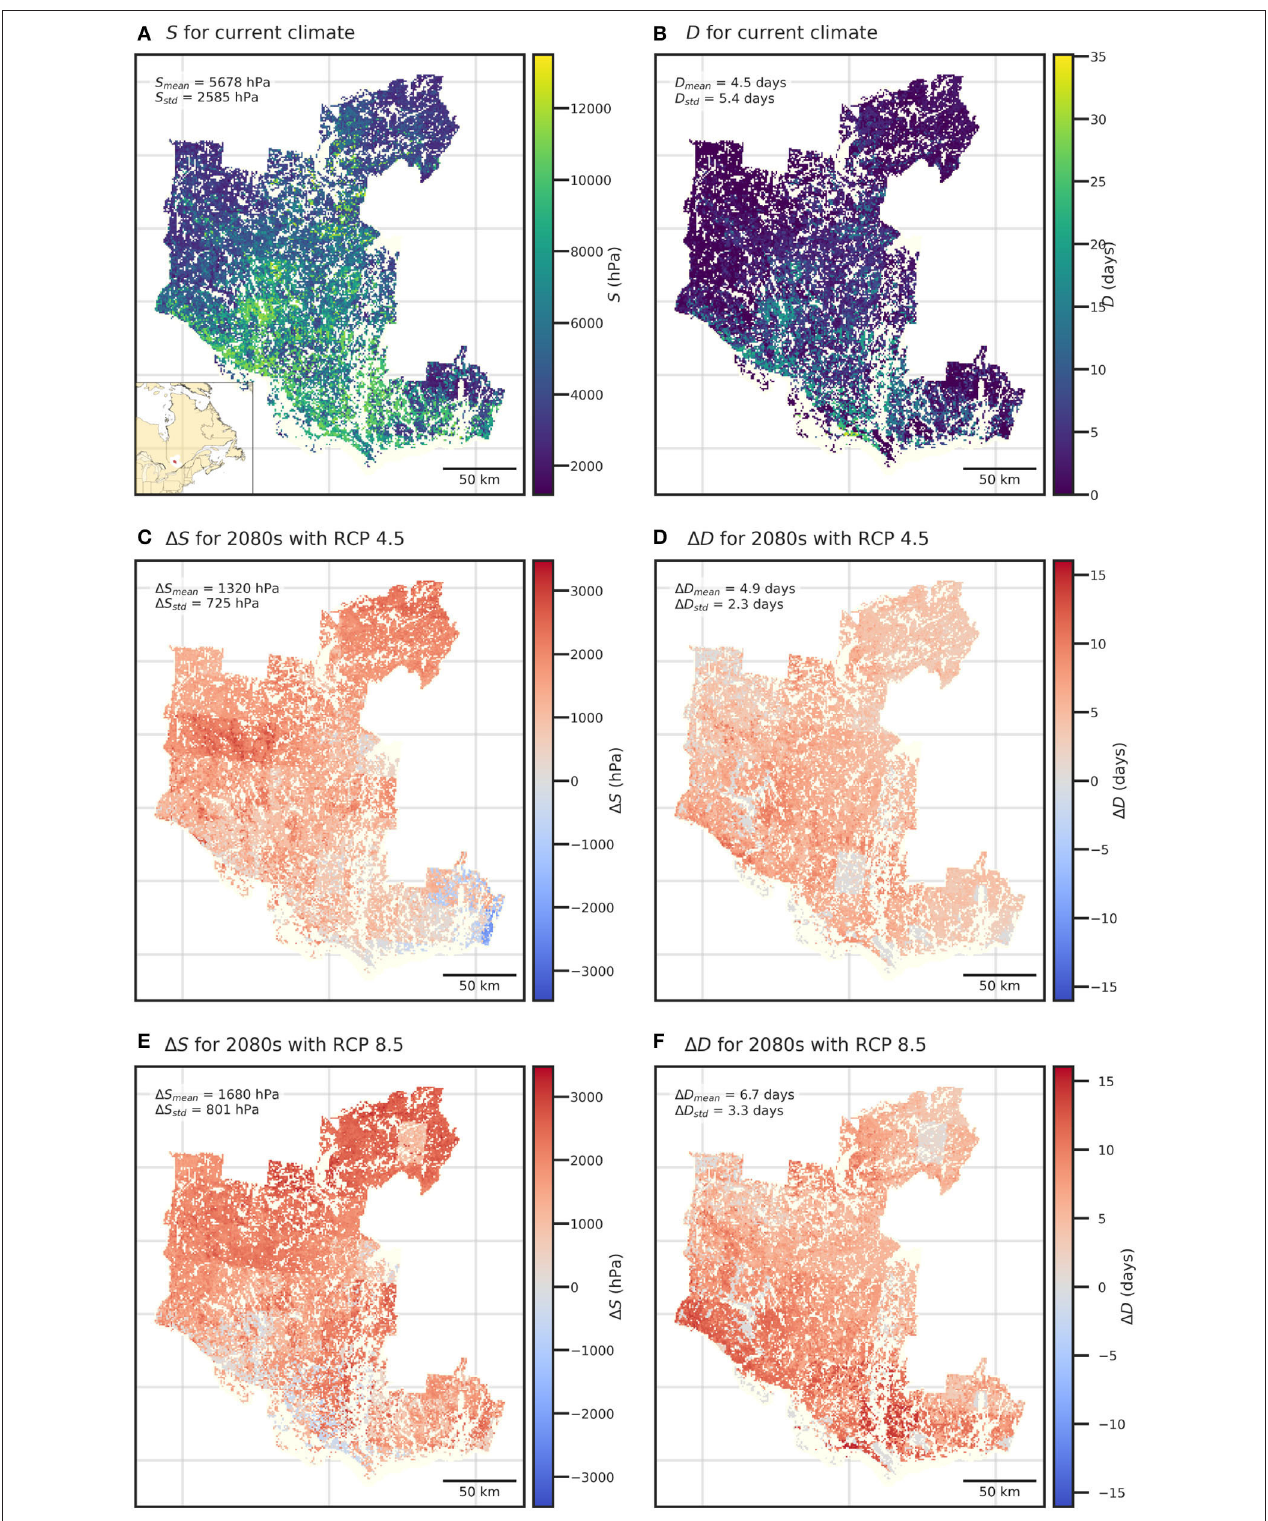
FIGURE 1 | Spatial distribution of the severity S and duration D of soil water stress under current climate conditions (A,B) and projected changes 1 S and 1 D for RCP4.5 (C,D) and RCP8.5 (E,F) for the 2080s. Ivory colored cells correspond to non-forested areas, i.e., grid cells with < 75% of forest cover.